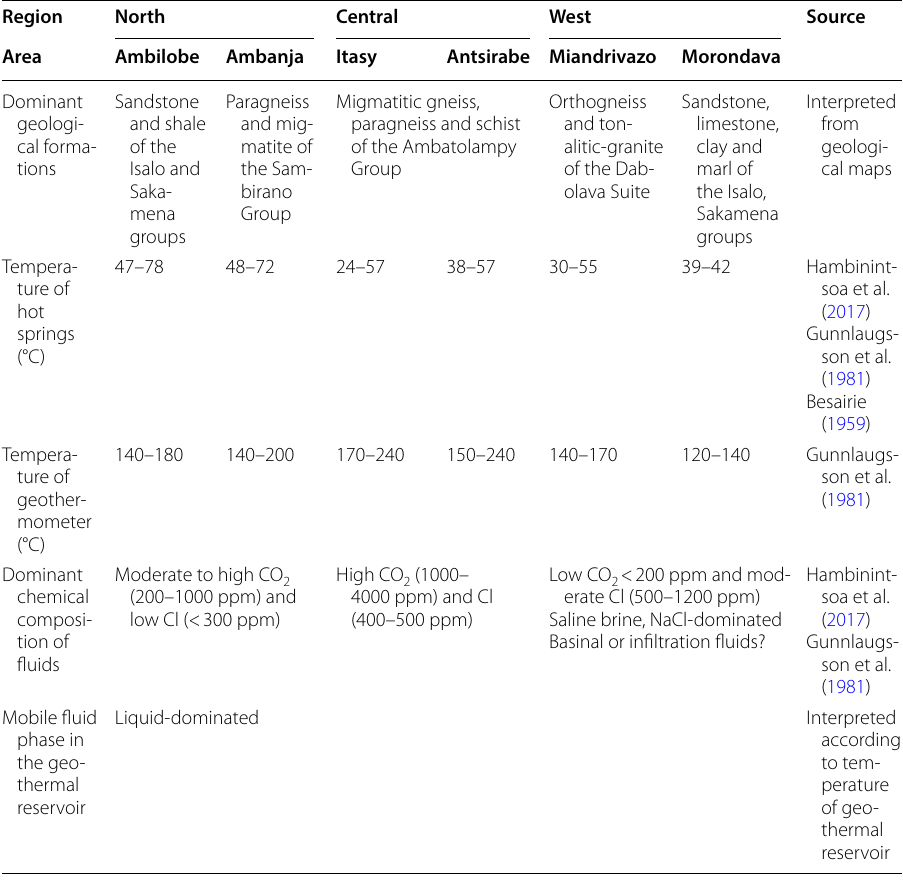
Table 3 Geological and geothermal characteristics for prospective areas in Madagascar Region